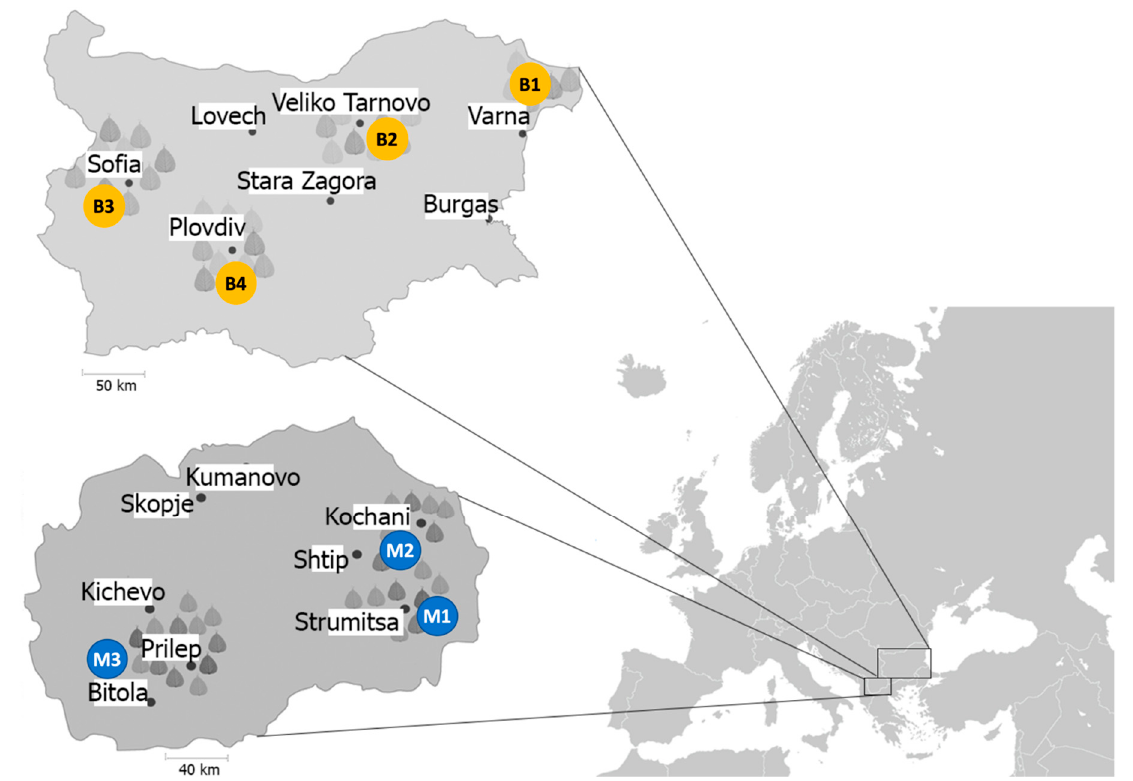
Figure 1. Geographic map depicting Europe with a close-up of Bulgaria (top) and North Macedonia (bottom) indicating the origin of the analysed strains, corresponding to four Bulgarian regions (B1 to B4) and three North Macedonian regions (M1 to M3).